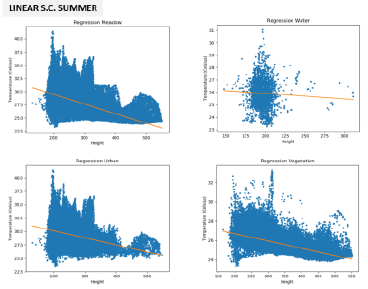
Figure 16: Linear Regression Model in Summer (Temperature – Land Cover)